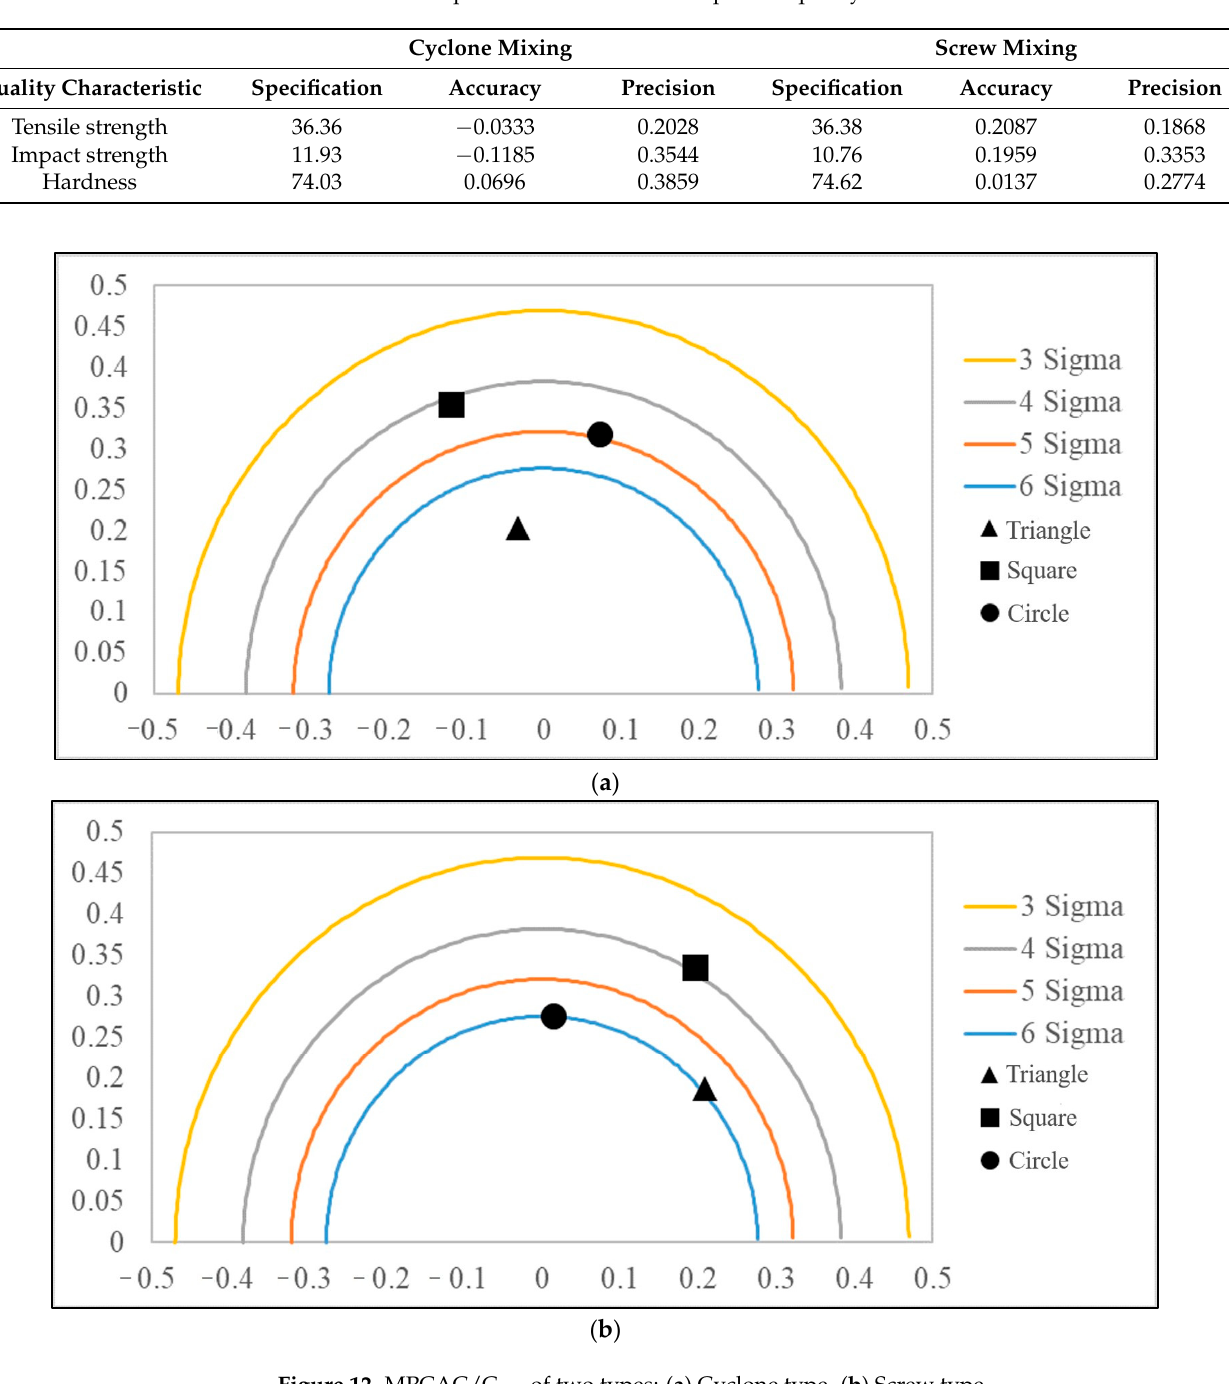
Table 14. Process parameter datasheet of important quality characteristics.